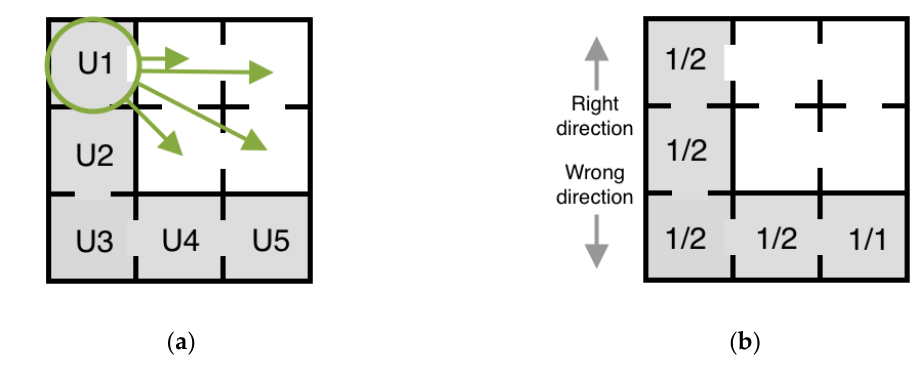
( b ) Figure A1. ( a ): Experimental systems showing the disturbed patches, A–D in white, and undisturbed patches, U1–U5 in grey; ( b ): Example showing the patches (indicated by arrows) used to calculate configuration at the patch scale for a disturbed patch, A (circled). Appendix A.3. System-Scale Configuration Metric At the whole-of-system scale, we varied the number and spatial arrangement of the connections linking disturbed and undisturbed patches. We combined two measures to represent ‘configuration’ at the system scale, to account for the way these connections increased in connectivity, and to account for the direction of the migration of animals through the system: (1) the average configuration of each undisturbed patch to each of the disturbed patches; and (2) the probability that a crab would walk in the right direction toward a disturbed patch to graze. For the first measure, the average configuration, we were interested in how closely connected all of the undisturbed patches were to the disturbed patches; thus, we adapted closeness centrality as follows: